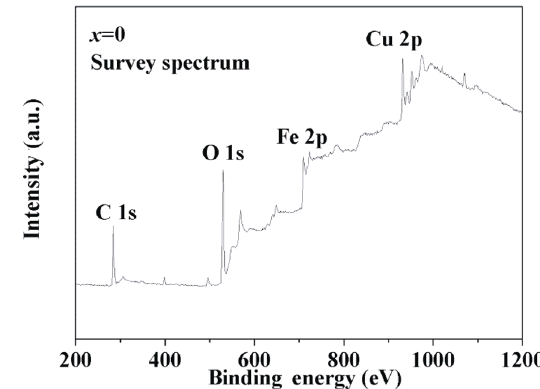
Fig. 2 Lattice parameters a and c of CuFe 1– x Mn x O 2 samples as a function of Mn content x . Fig. 3 Survey spectrum of the x = 0